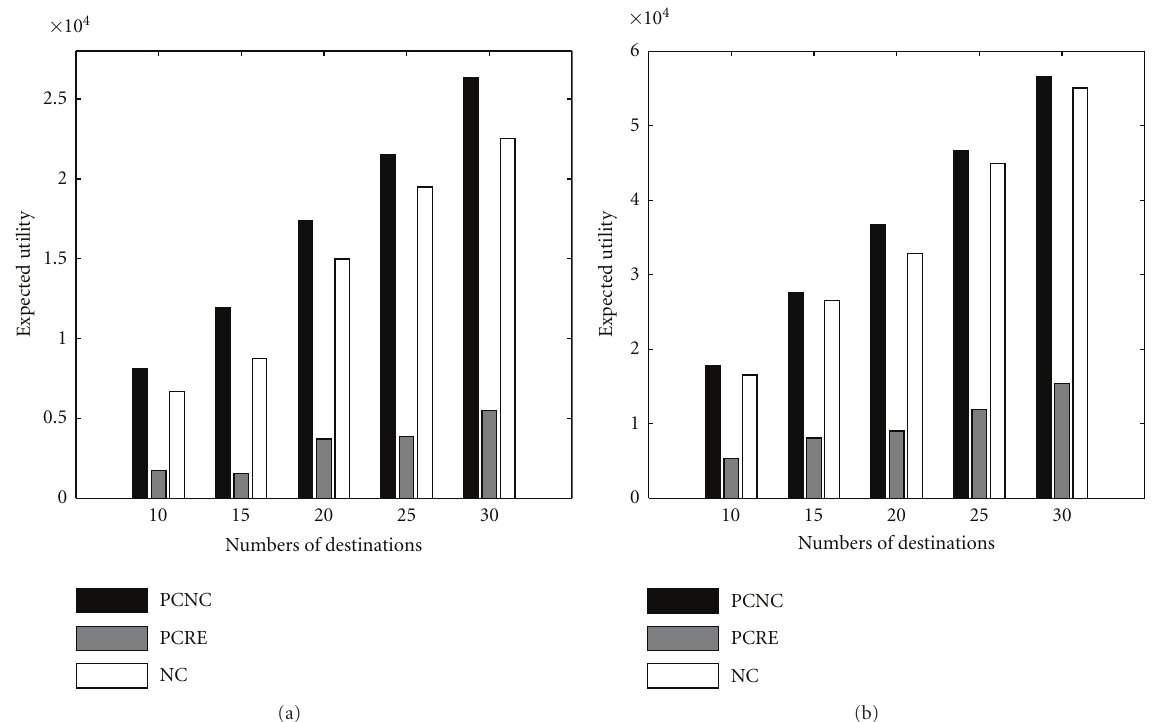
Figure 7: The comparison among three schemes (PCNC, PCRE, NC) with di ff erent numbers of destinations for mulitcast routing, when (a) A = 1000 (b) A =